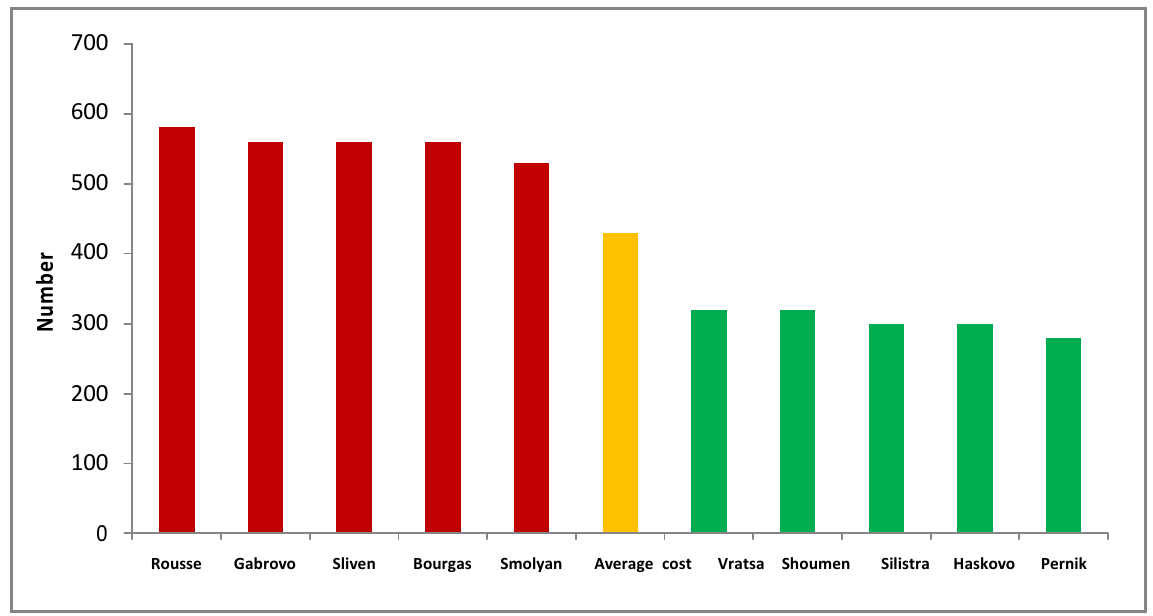
Figure 2. Average cost per patient (in BGN) for the treatment of non-insulin dependentdiabetes in Bulgaria in 2013 (Source: NHIF Report for June2014)